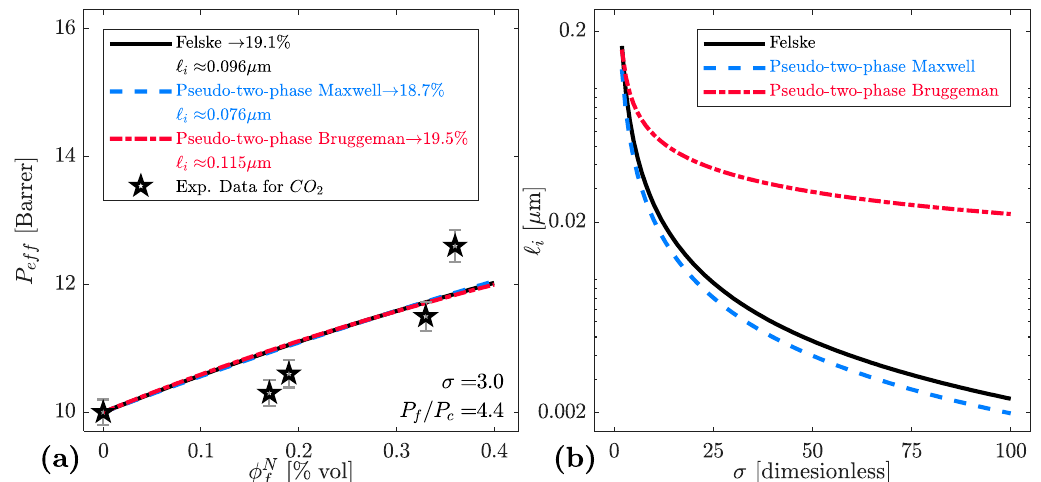
Figure 11. Comparison of the effective permeability and interfacial thickness profiles based on various non-ideal EMA models by fitting experimental permeation data for CO 2 in CMS/Matrimid 5218 MMMs from [46], with α fc = P f / P c = 4.4: ( a ) effective permeability vs. nominal filler volume fraction and ( b ) thickness vs. chain immobilization factor.